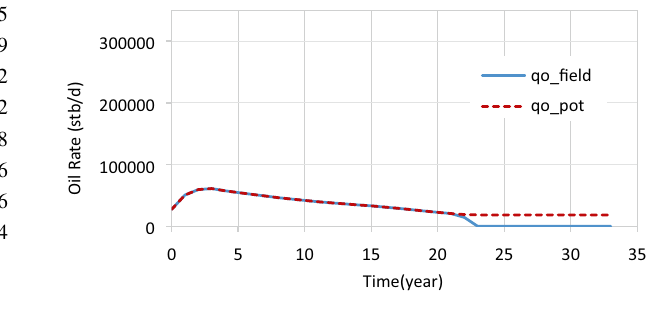
Fig. 19 Optimum oil production profile and oil production potential for strategy Tie-back with GL